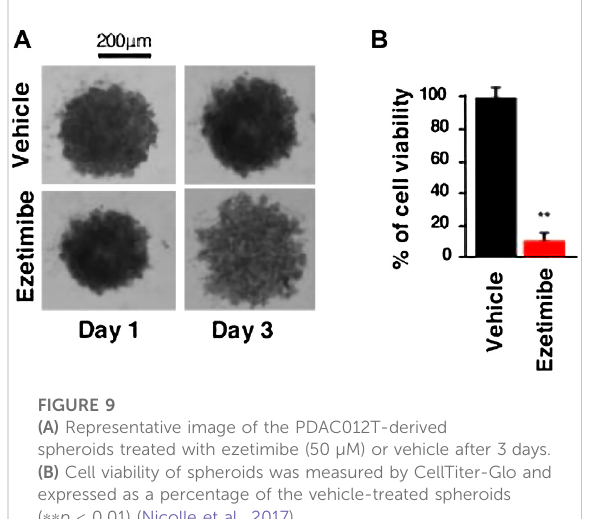
FIGURE 9 (A) Representative image of the PDAC012T-derived spheroids treated with ezetimibe (50 µM) or vehicle after 3 days. (B) Cell viability of spheroids was measured by CellTiter-Glo and expressed as a percentage of the vehicle-treated spheroids ( pp p < 0.01) (Nicolle et al.,